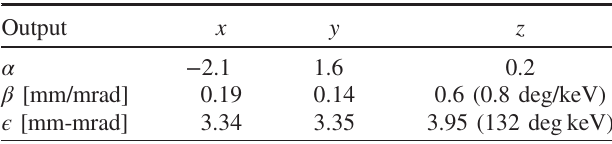
TABLE III. Output emittances from PARMTEQ simulation of RFQ. Emittances are